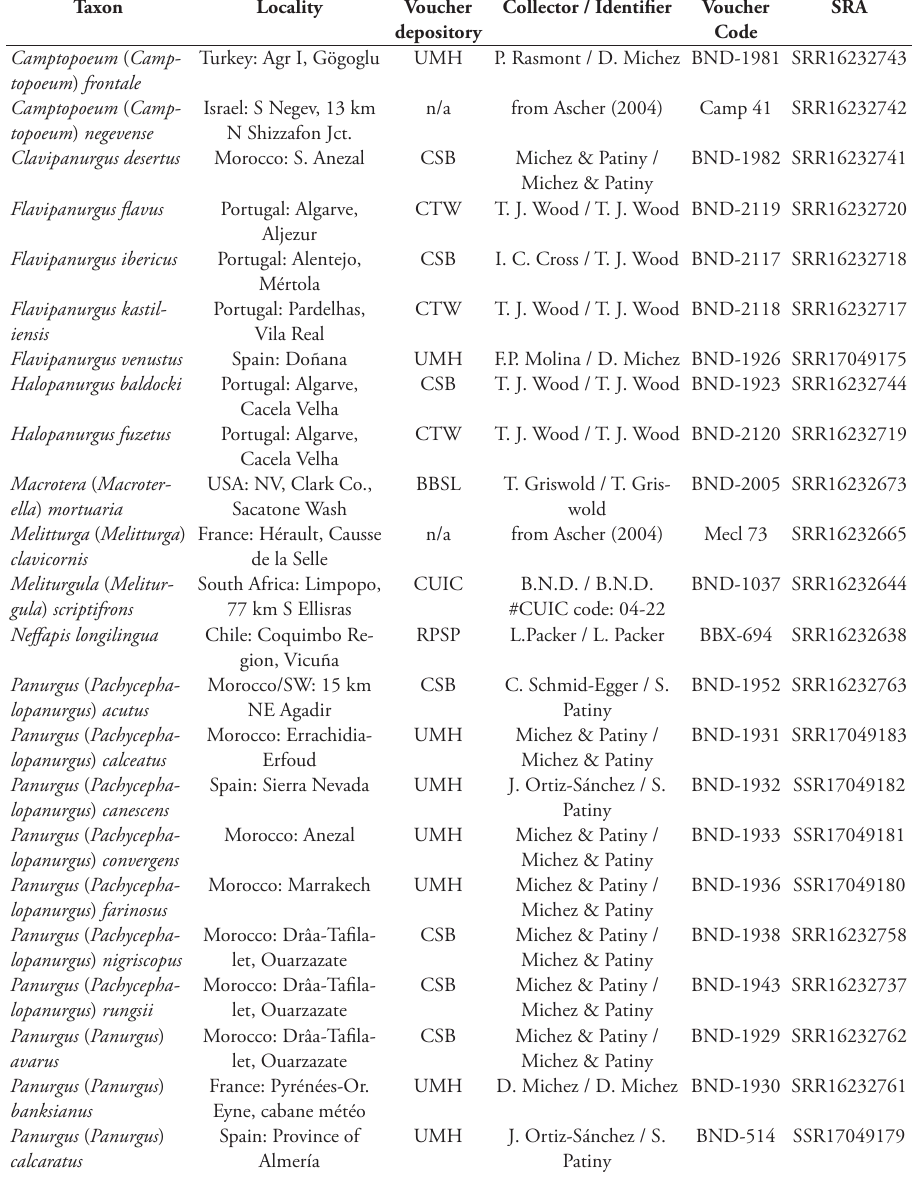
Table 1. The scientific names of the included species with their collection localities and voucher de- positories. NCBI SRA IDs marked with an asterisk (*) indicate samples that are newly published. Most voucher specimens are labelled with a green coloured label which carries the voucher code. UCE assem- blies of the newly generated sequence are available on the FighShare repository associated with this article (10.6084/m9.figshare.15033552). Acronyms for the collection depositories: Cornell Univ. Insect Col- lection (CUIC); Collection Silas Bossert (CSB); University of Mons-Hainaut, Mons, Belgium (UMH); Collection Thomas Wood, Mons, Belgium